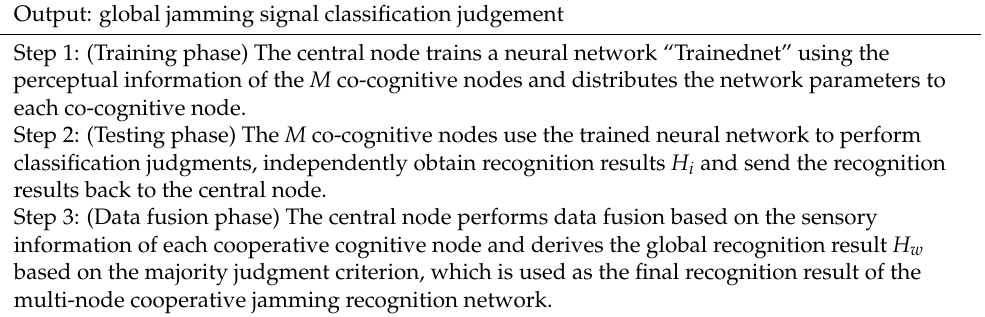
Table 3. Multi-node cooperative jamming recognition method based on hard